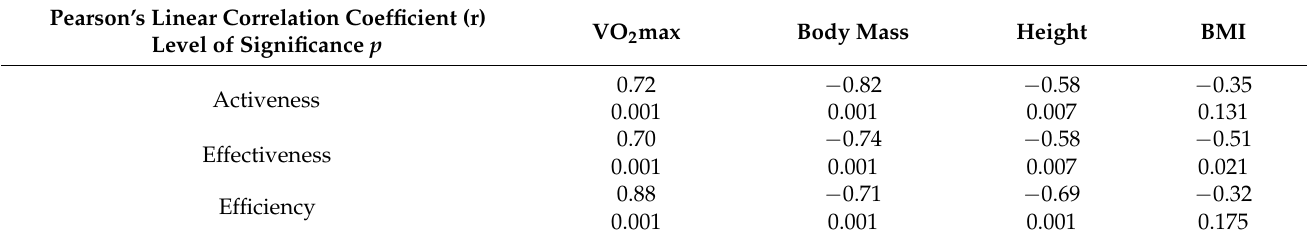
Table 6. The influence of selected variables on the activeness, the effectiveness and the efficiency of attacks. Pearson’s Linear Correlation Coefficient